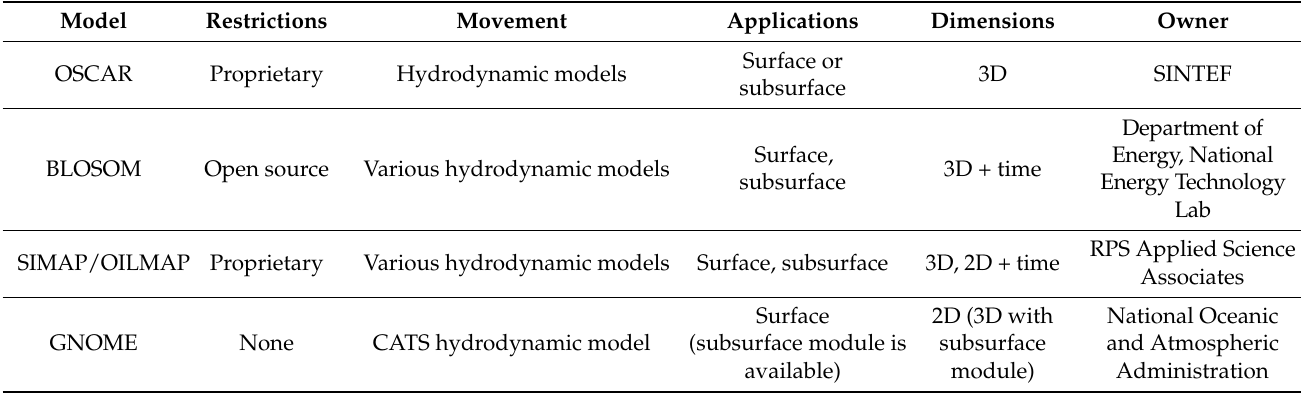
Table 6. Comparative information of different oil spill models